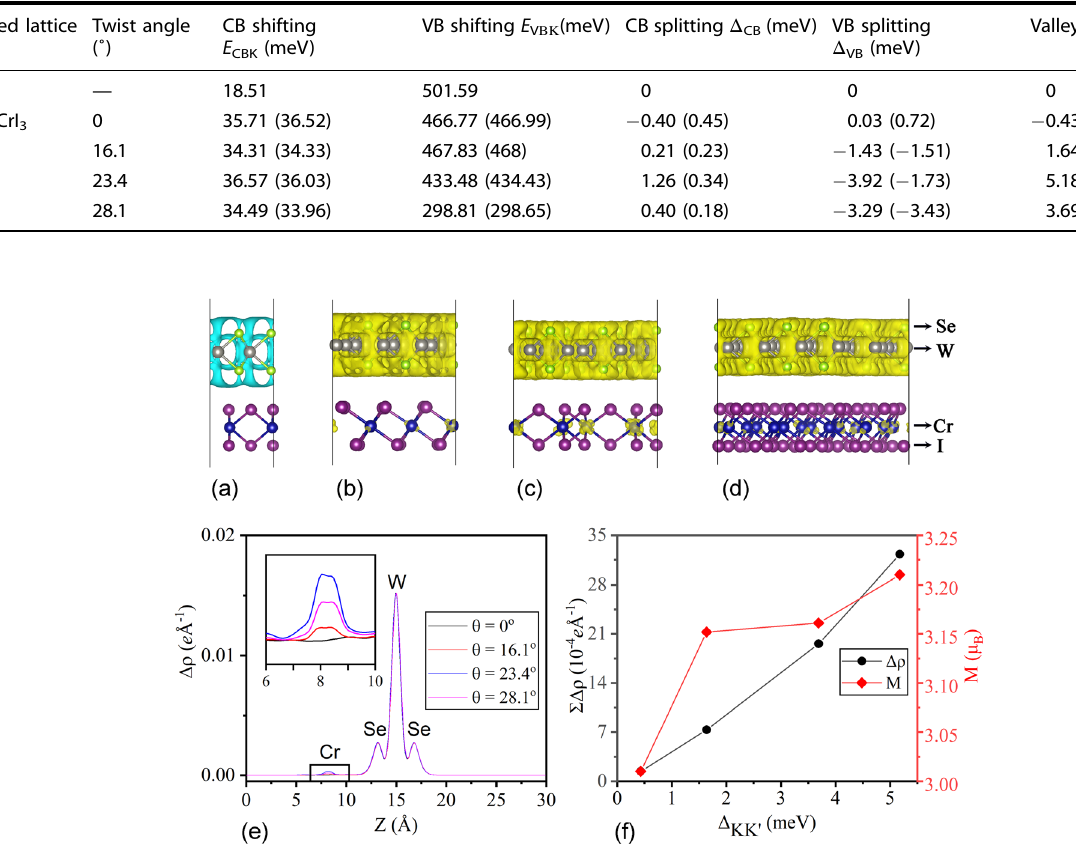
Fig. 5 Partial charge density differences of the VBM states between K and K ′ for different θ . a θ = 0, b 16.1, c 23.4, and d 28.1 ˚ . Isosurface is set at 5 × 10 -5 e Å -3 . e Planar averaged partial charge density differences along z for states in ( a – d ). Inset is a zoom-in of the framed region at around z = 8 Å. f ΣΔρ and average magnetic moment of Cr atom M as functions of valley splitting Δ KK ′ .